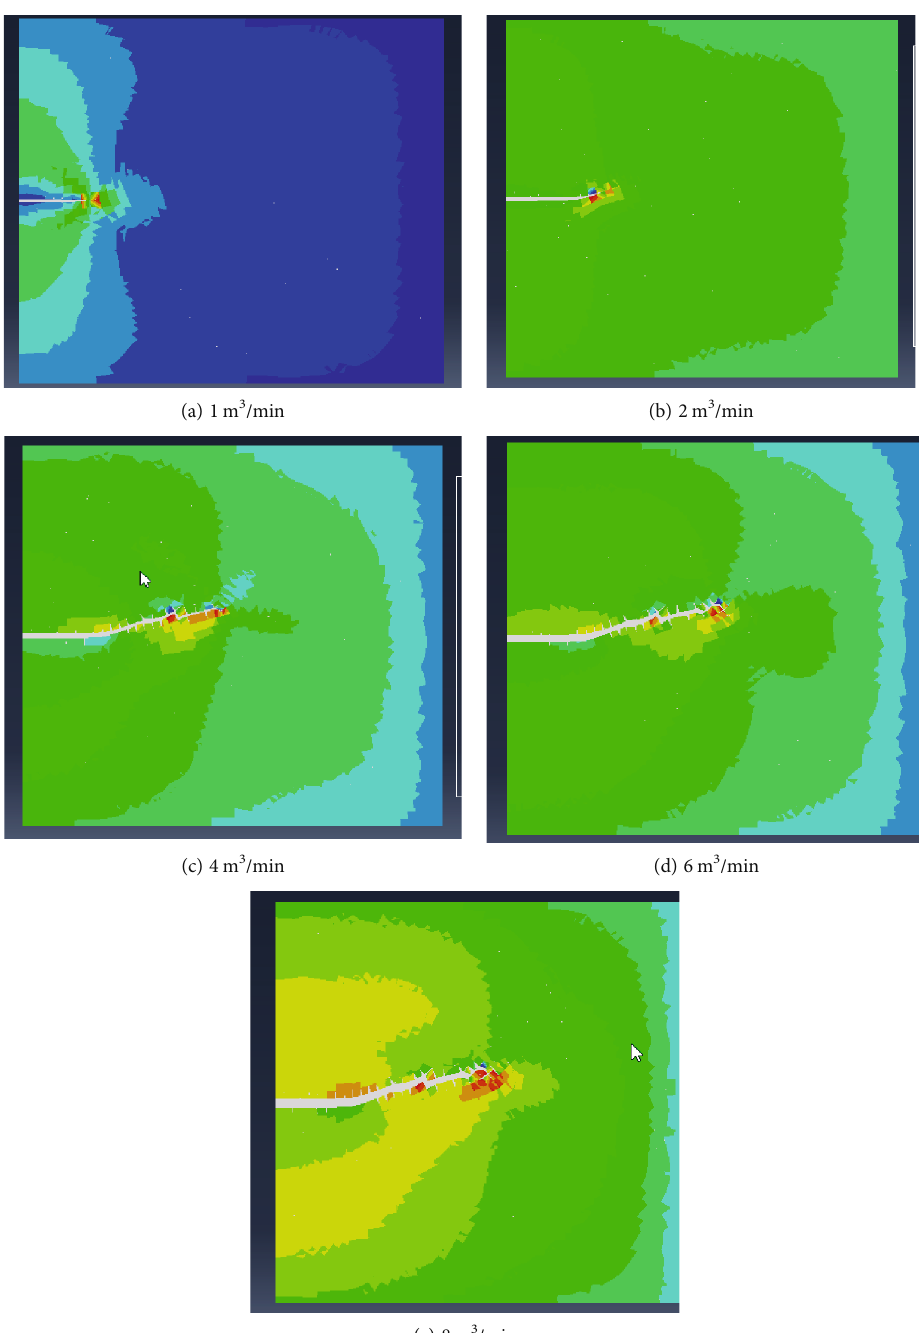
° and at the rate of 1 m 3 /min, 2 m 3 /min, 4m 3 /min, 6m 3 / 11 at the NF approaching angle of 30